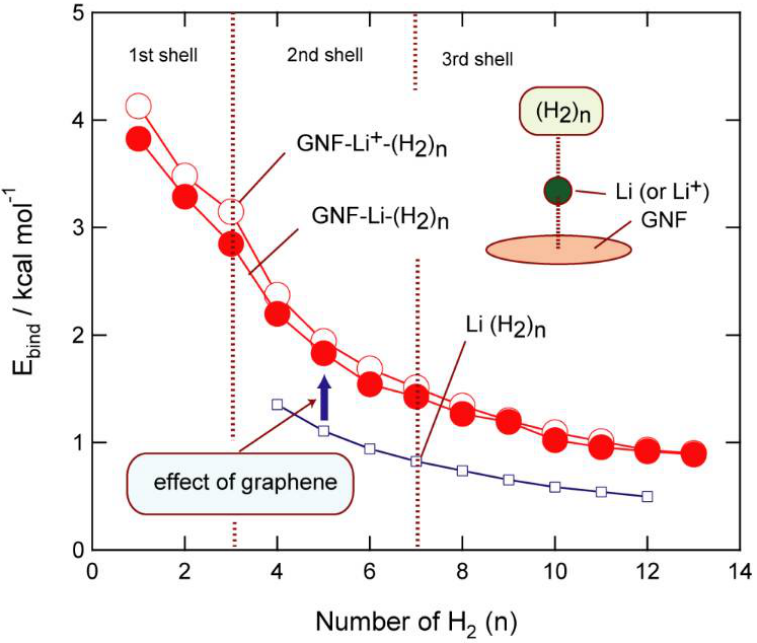
Figure 3. The binding energies of H 2 to GNF(37)-Li and GNF(37)-Li + (per H 2 molecule) plotted as a function of the number of hydrogen molecules ( n ). The open squares represent the binding energies of H 2 to the Li atom without GNF, Li(H 2 ) n . Calculations were performed at the CAM-B3LYP/6-311G(d,p) level. Reprinted with permission from [38]. Copyright 2019 American Chemical Society.